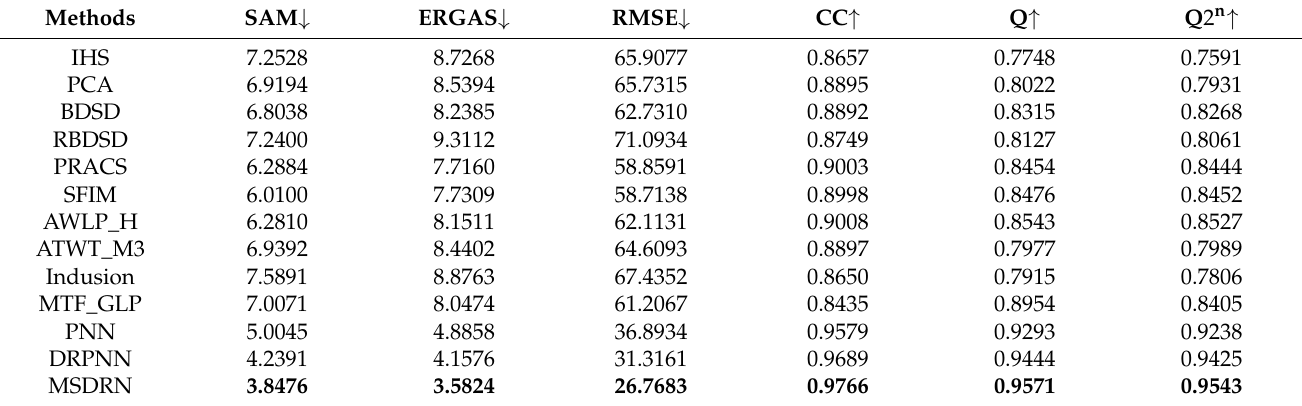
The best values in the tables are marked in bold. Table 5. Quantitative evaluation comparison of fusion results on the QuickBird